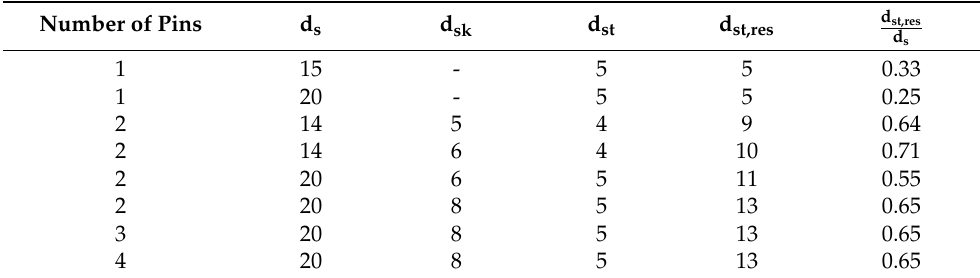
Table 5. Process relevant tool dimensions and